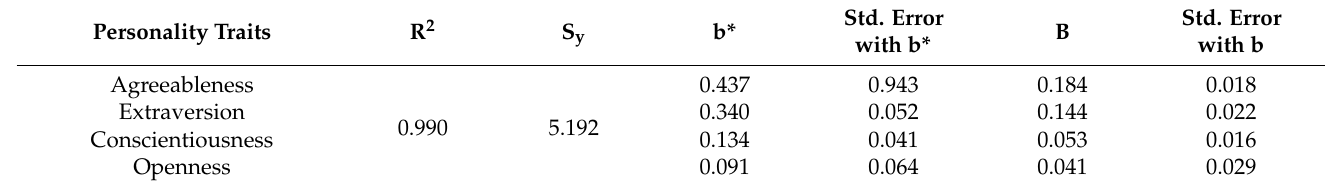
Table 5. Correlations between personality traits in the Big Five model and the overall index of proper peri-exercise nutrition among athletes training team sports (multiple regression